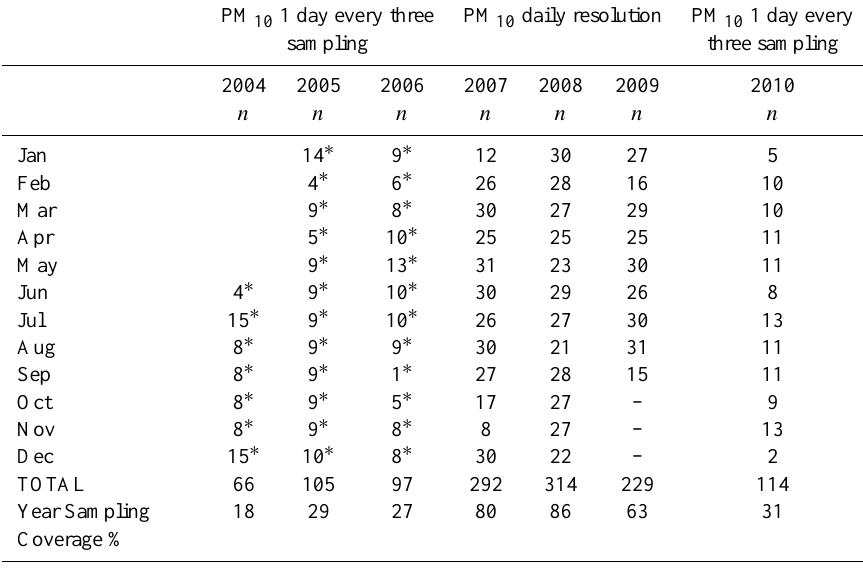
Table 1. Number of PM 10 samples collected in each month from June 2004 to December